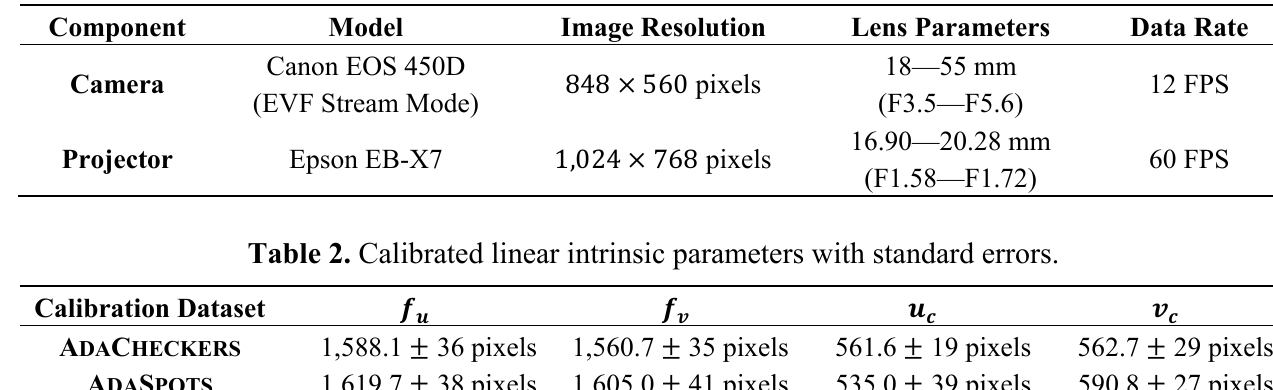
Table 1. Hardware specification in the setup of the project-camera system.